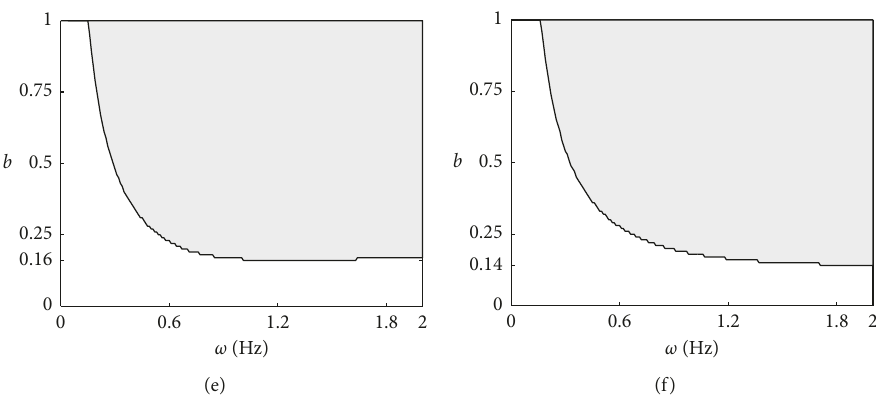
Figure 5: Mean square stability charts to equation (8) for the values η (d) c 1 . 0; (e) c 1 . 5; (f) c 2 . 0. The instability regions are (cid:29) (cid:29) (cid:29)